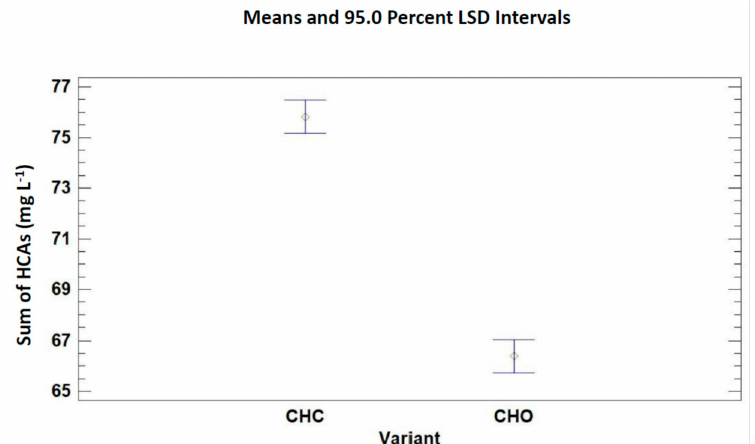
Figure 7. Significant differences between the Chardonnay variants in the sum of the hydroxycinnamic acids